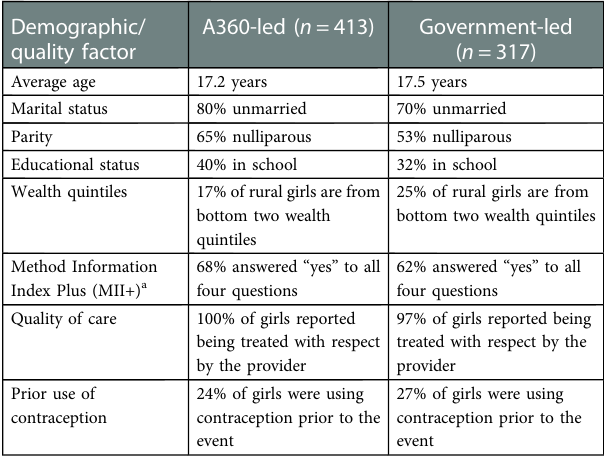
TABLE 2 Client demographic and counseling outcome comparison between A360-led and government-led Kuwa Mjanja implementation. Demographic/ quality factor